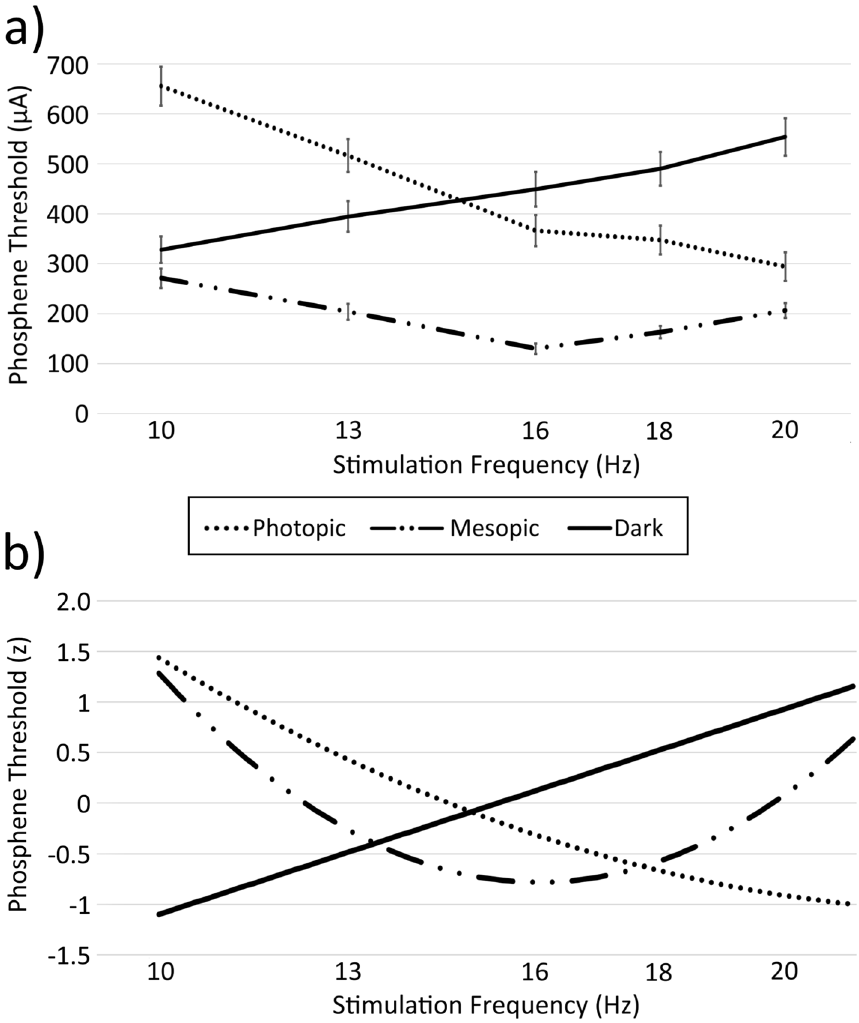
Figure 2. ( a ) Phosphene thresholds and standard errors for each ambient lighting condition at each frequency tested (10, 13, 16, 18 and 20 Hz). ( b ) Regression-based estimates of normalised phosphene thresholds, as a function of stimulation frequency, for each ambient lighting condition.